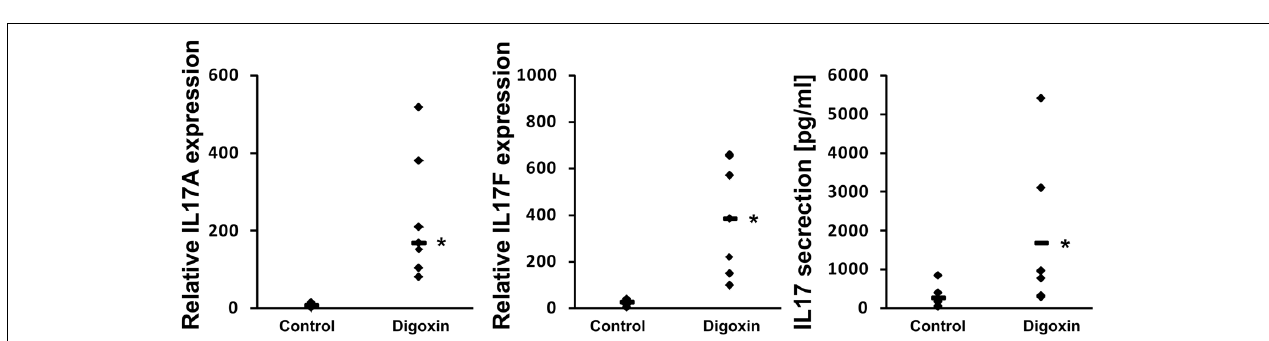
FIGURE 5 | Analysis of the binding of ROR γ , NCOA1 and NCOA2 in vivo to the promoter sequences of the G6PC (A) and NPAS2 (B) genes in HepG2 cells after treatment with digoxin as evidenced by chromatin immunoprecipitation. Cells were treated with 100 nM digoxin for 8 h and then analyzed using chromatin immunoprecipitation. Mean ± SD, n = 3, ∗ significantly different from the control treatment at p < 0.05.